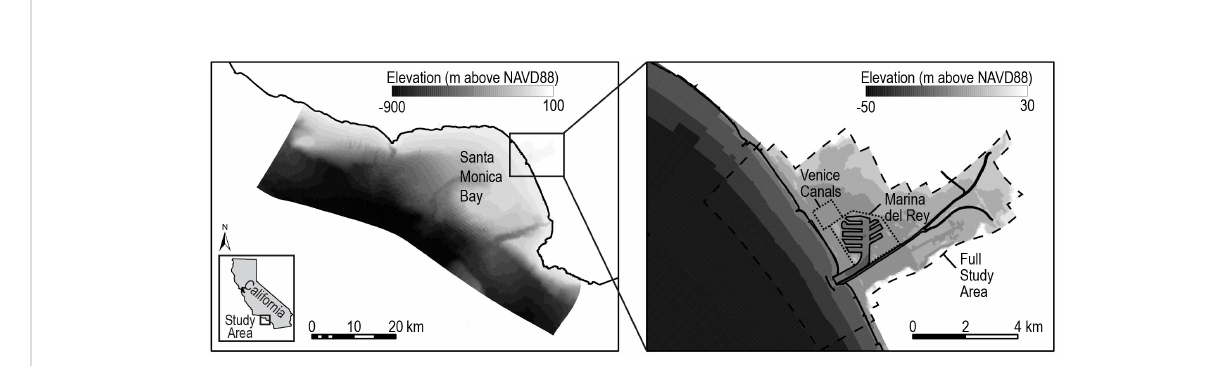
FIGURE 1 Map of the full hydrodynamic model domain covering Santa Monica Bay, California, and including Marina del Rey and the Venice Canals. The full study area considered for the physical, economic, and demographic impact analysis is outlined by a dashed